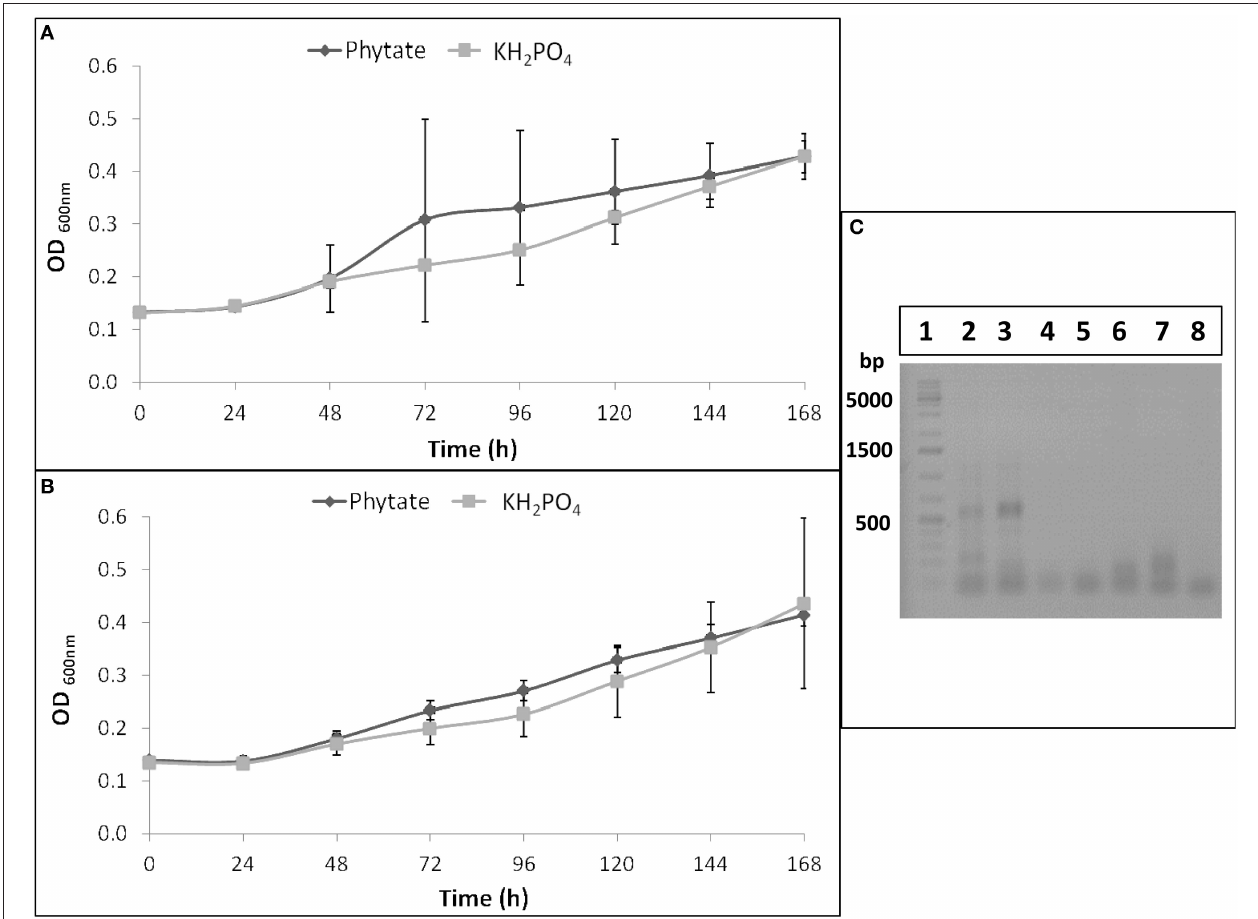
FIGURE 1 | B. elkanii SEMIA 587 growth curves in Angle medium at pH 6 (A) or at pH 7 (B) supplemented with 1.5mM KH 2 PO 4 (light gray) or with 6mM Na-phytate (dark gray). Data represent average and standard deviation of three replicates. (C) RT-PCR or PCR products of B. elkanii SEMIA 587 grown in Angle medium supplemented with Na-phytate or with KH 2 PO 4 as P source in 1% agarose gel. Lane 1, GeneRuler 1kb Plus DNA Ladder (Thermo Scientific); Lane 2, RT-PCR performed with HAP primers and cDNA as template obtained from SEMIA 587 cultivated with phytate as P source; Lane 3, RT-PCR performed with HAP primers (and BSA) and cDNA as template obtained from SEMIA 587 cultivated with phytate as P source; Lane 4, RT-PCR performed with BPP primers and cDNA as template obtained from SEMIA 587 cultivated with phytate as P source; Lane 5, PCR performed with HAP primers (and BSA) and gDNA as template obtained from SEMIA